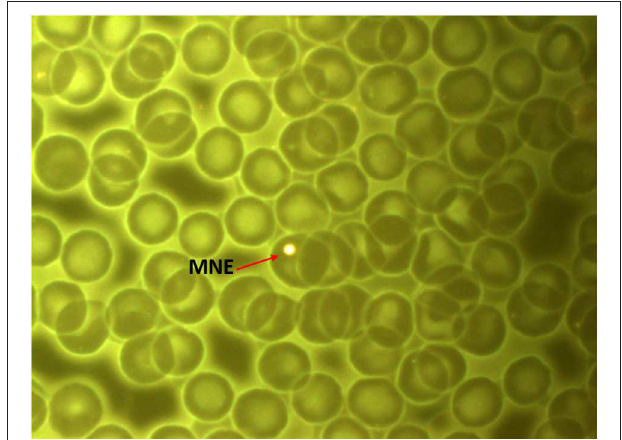
FIGURE 1 | Peripheral blood smear of the subject cat ( Felis catus domesticus ). Red arrow: Micronucleated erythrocyte. Stain Fluorescence IVFL filter 450–490 nanometers. Axiostar Plus microscope. Planachromatic objective 100x/1.25 oil. Axiocam camera 1cc. 1000 real increases.